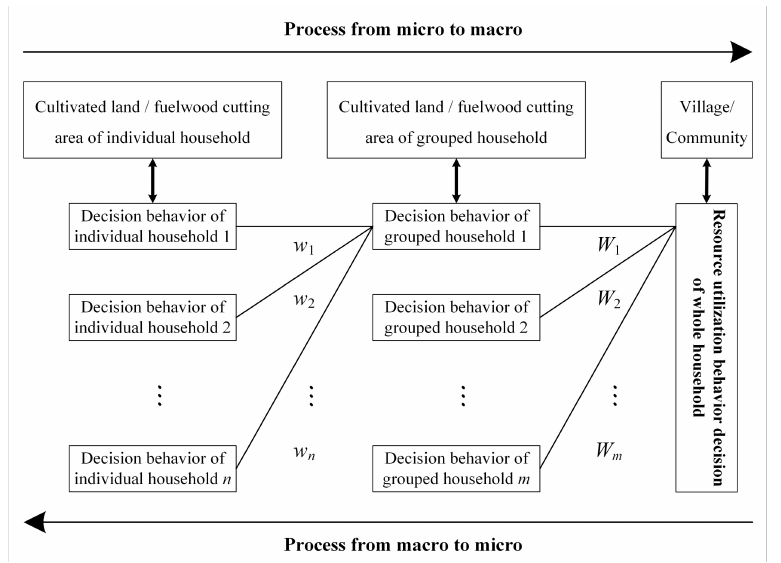
Figure 1. Spatial manifestation and transformation mechanism of households’ resource utilization behavior